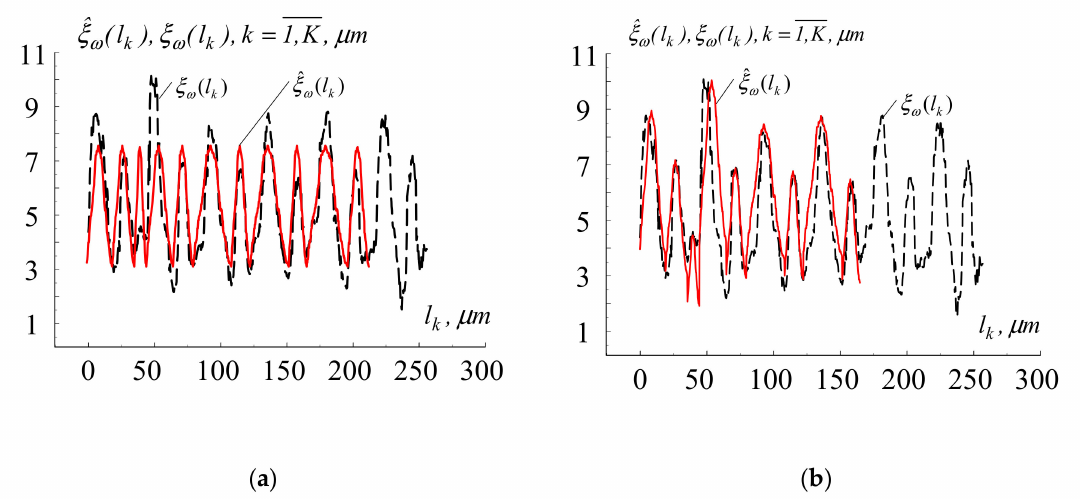
Figure 4. The result of modeling the surface microrelief of titanium alloy Ti6Al4V after processing with femtosecond pulses: ( a ) based on the well-known mathematical model [14]; ( b ) based on the proposed mathematical model (red line—experimental data; black line—results of